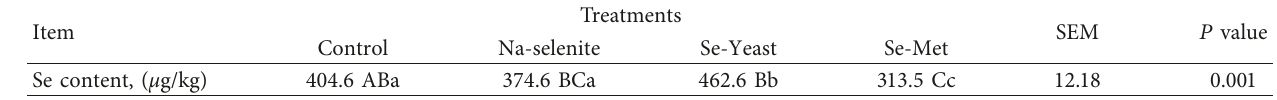
Table 5: Selenium content in hen